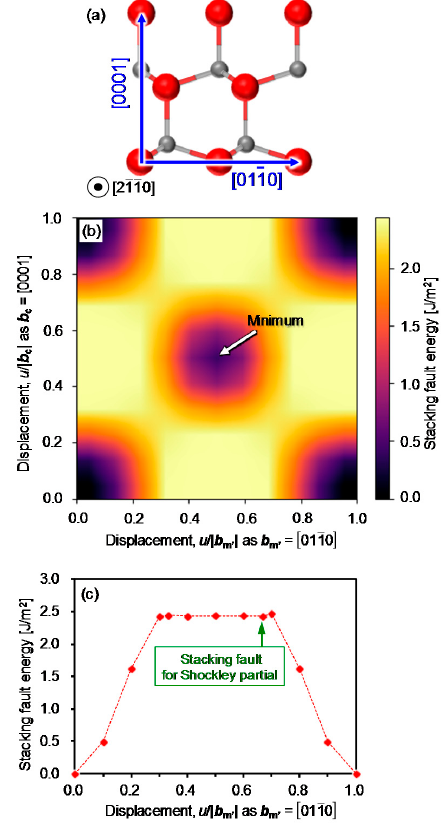
Figure 8. ( a ) Schematic illustration showing the [0001] and [0110] vectors on (2110). ( b ) A map of stacking fault energies on (2110) in ZnO. This map indicates the minimum value of 0.40 J/m 2 at the center, where the fault vector is 1/2[0111]. ( c ) Stacking fault energies along [0110] on (2110) in ZnO, where the fault vector does not have the component along [0001]. Here, the (2110) stacking fault with the 2/3[0110] fault vector indicated by the green arrow in ( c ) is the same as that with the 1/3[0110] fault vector. In addition, owing to the symmetry of the wurtzite crystal structure, the (2110) stacking fault with the 1/3[0110] fault vector is equivalent to the (2110) stacking fault with the 1/3[1010] fault vector, which corresponds to a Burgers vector of the Shockley partials in ZnO. Eventually, the energy of the stacking fault with the 2/3[0110] fault vector in ( c ) represents the energy of a stacking fault structure that would arise by the hypothetical Shockley dissociation on